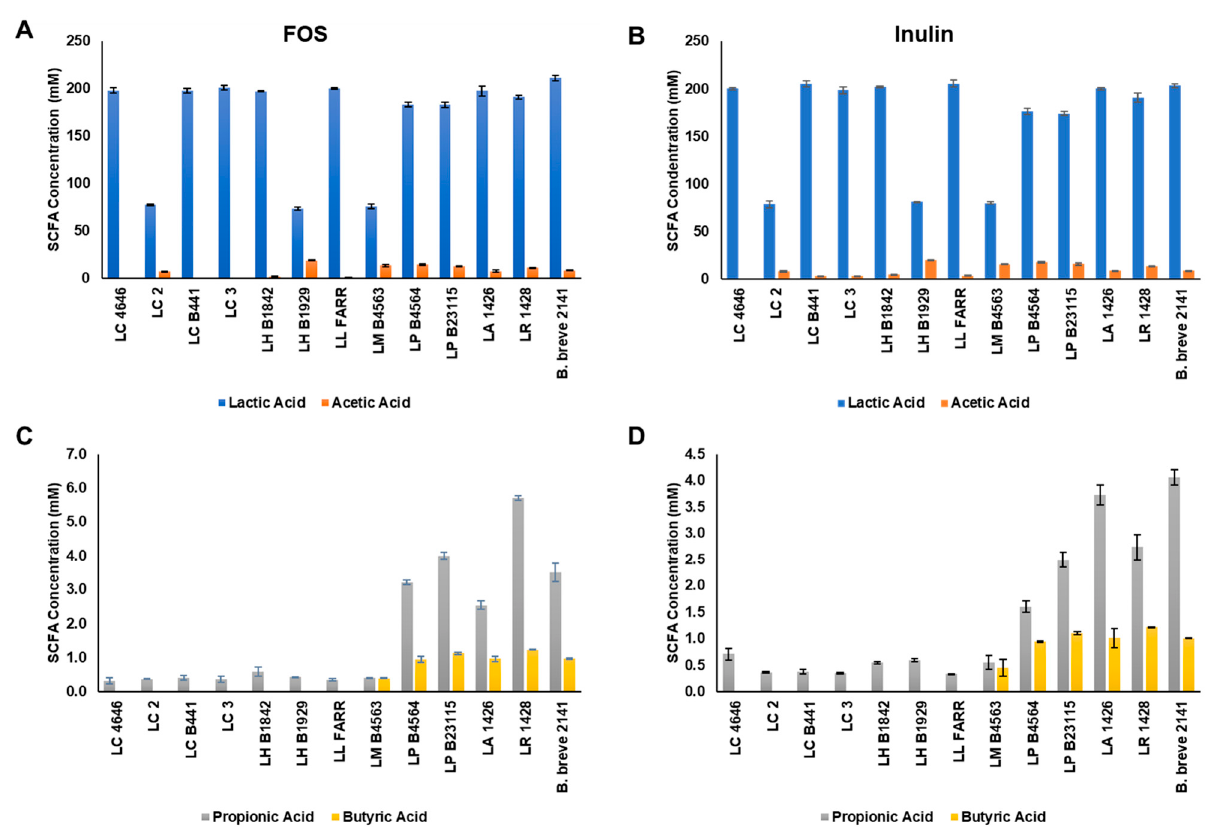
Figure 4. Short-chain fatty acid production by the ten Lactobacillus strains capable of fermenting both ( A , C ) FOS and ( B , D ) inulin. Bars represent the average concentration of each SCFA (nM): lactic (blue bars), acetic (orange bars), propionic acids (gray bars), and butyric acids (yellow bars) as the average of three replicates ( ± standard